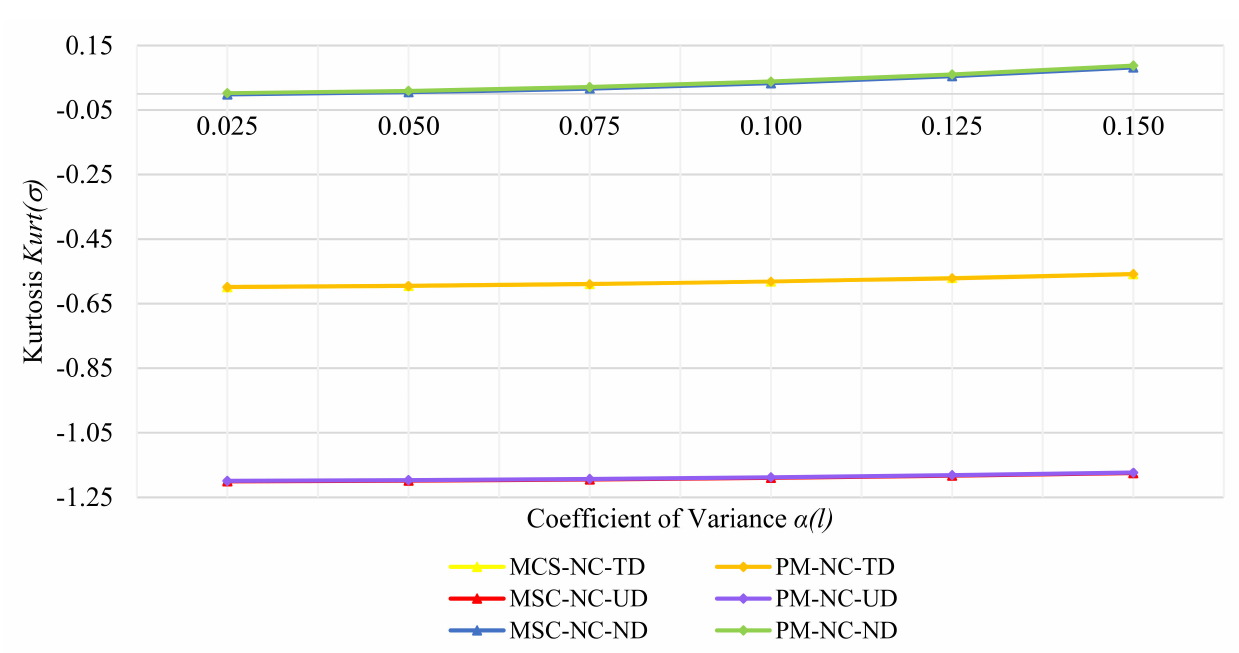
Figure 16. Kurtosis Kurt in the